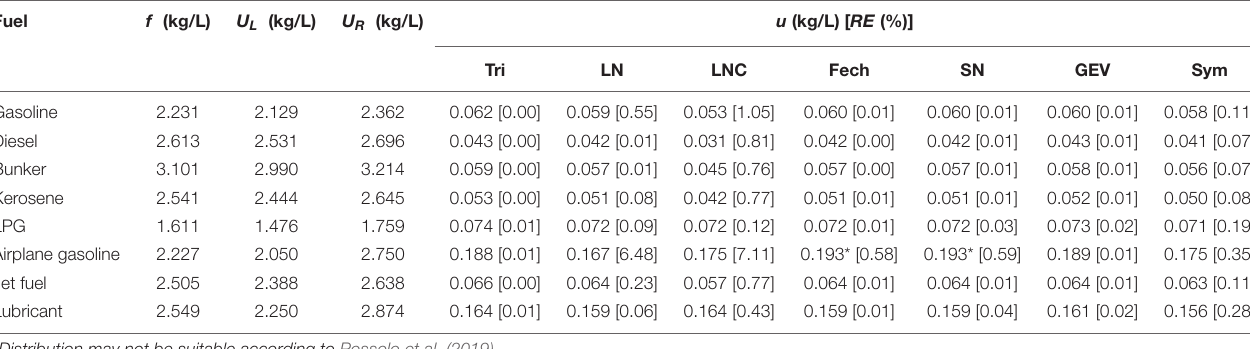
TABLE 1 | Absolute standard uncertainties u and largest relative error RE estimated for CO 2 emission factors for the fuel sector using various asymmetric approaches. The best estimate f and expanded asymmetric uncertainties U L and U R were taken from the official database of Costa Rican emission factors (IMN, 2020). Values of RE are shown inside the brackets.